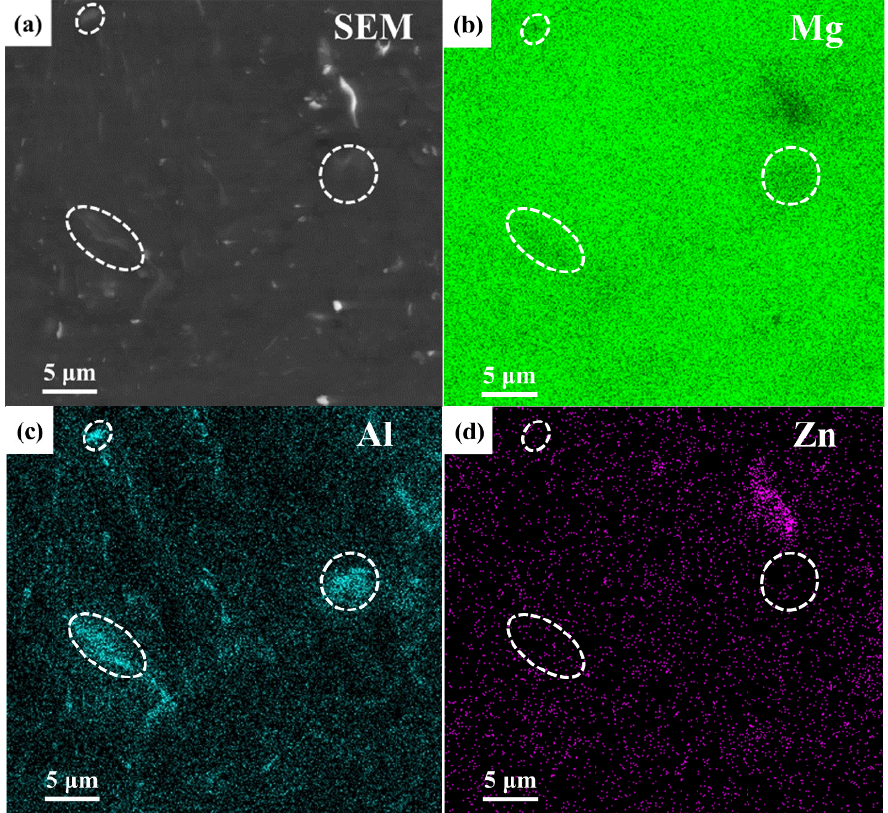
Figure 6. The microstructure milled Mg-9Al-Zn-0.3Mn alloy: ( a ) BSE image, ( b – d ) element distribution results.